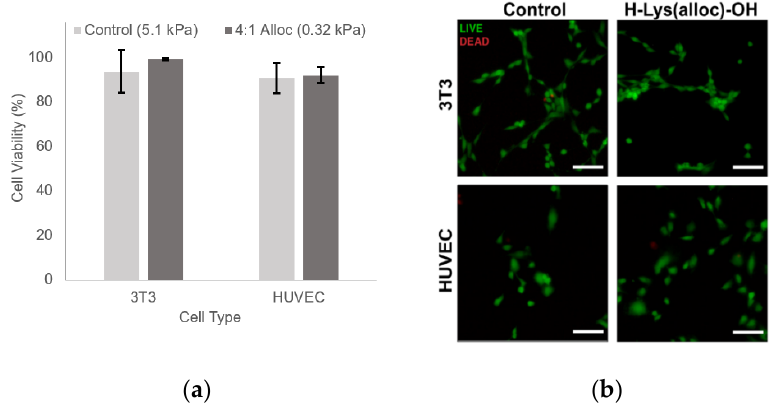
Figure 6. Addition of H-Lys(alloc)-OH does not significantly reduce cell viability. ( a ) percentage of live cells at 72 h after seeding. Values reported as mean ± S.D. n = 4. n.s. indicates no significant difference. 3T3: p = 0.35, HUVEC: p = 0.74. Statistical analysis evaluated by Student’s t -test; ( b ) Live/Dead images at 72 h after seeding. Scale bar = 100 µm.